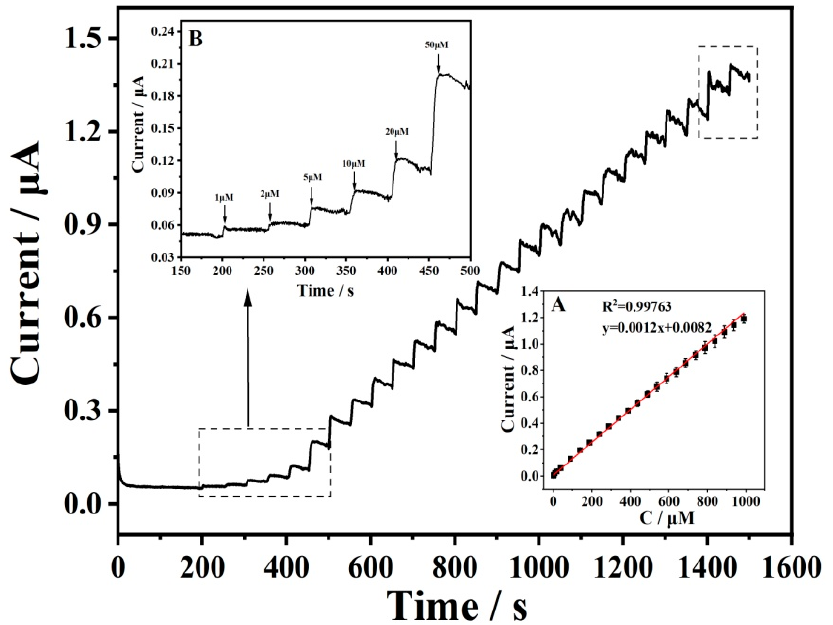
Figure 8. Amperometric response of EGO 1/1.75V to the successive injection of GSH in a stirred 0.1M PBS (pH 4.5) at an applied potential of 0.2 V. Inset ( A ) is the calibration curve for the steady- state current upon the addition of different GSG levels. Inset ( B ) is the amperometric response at low